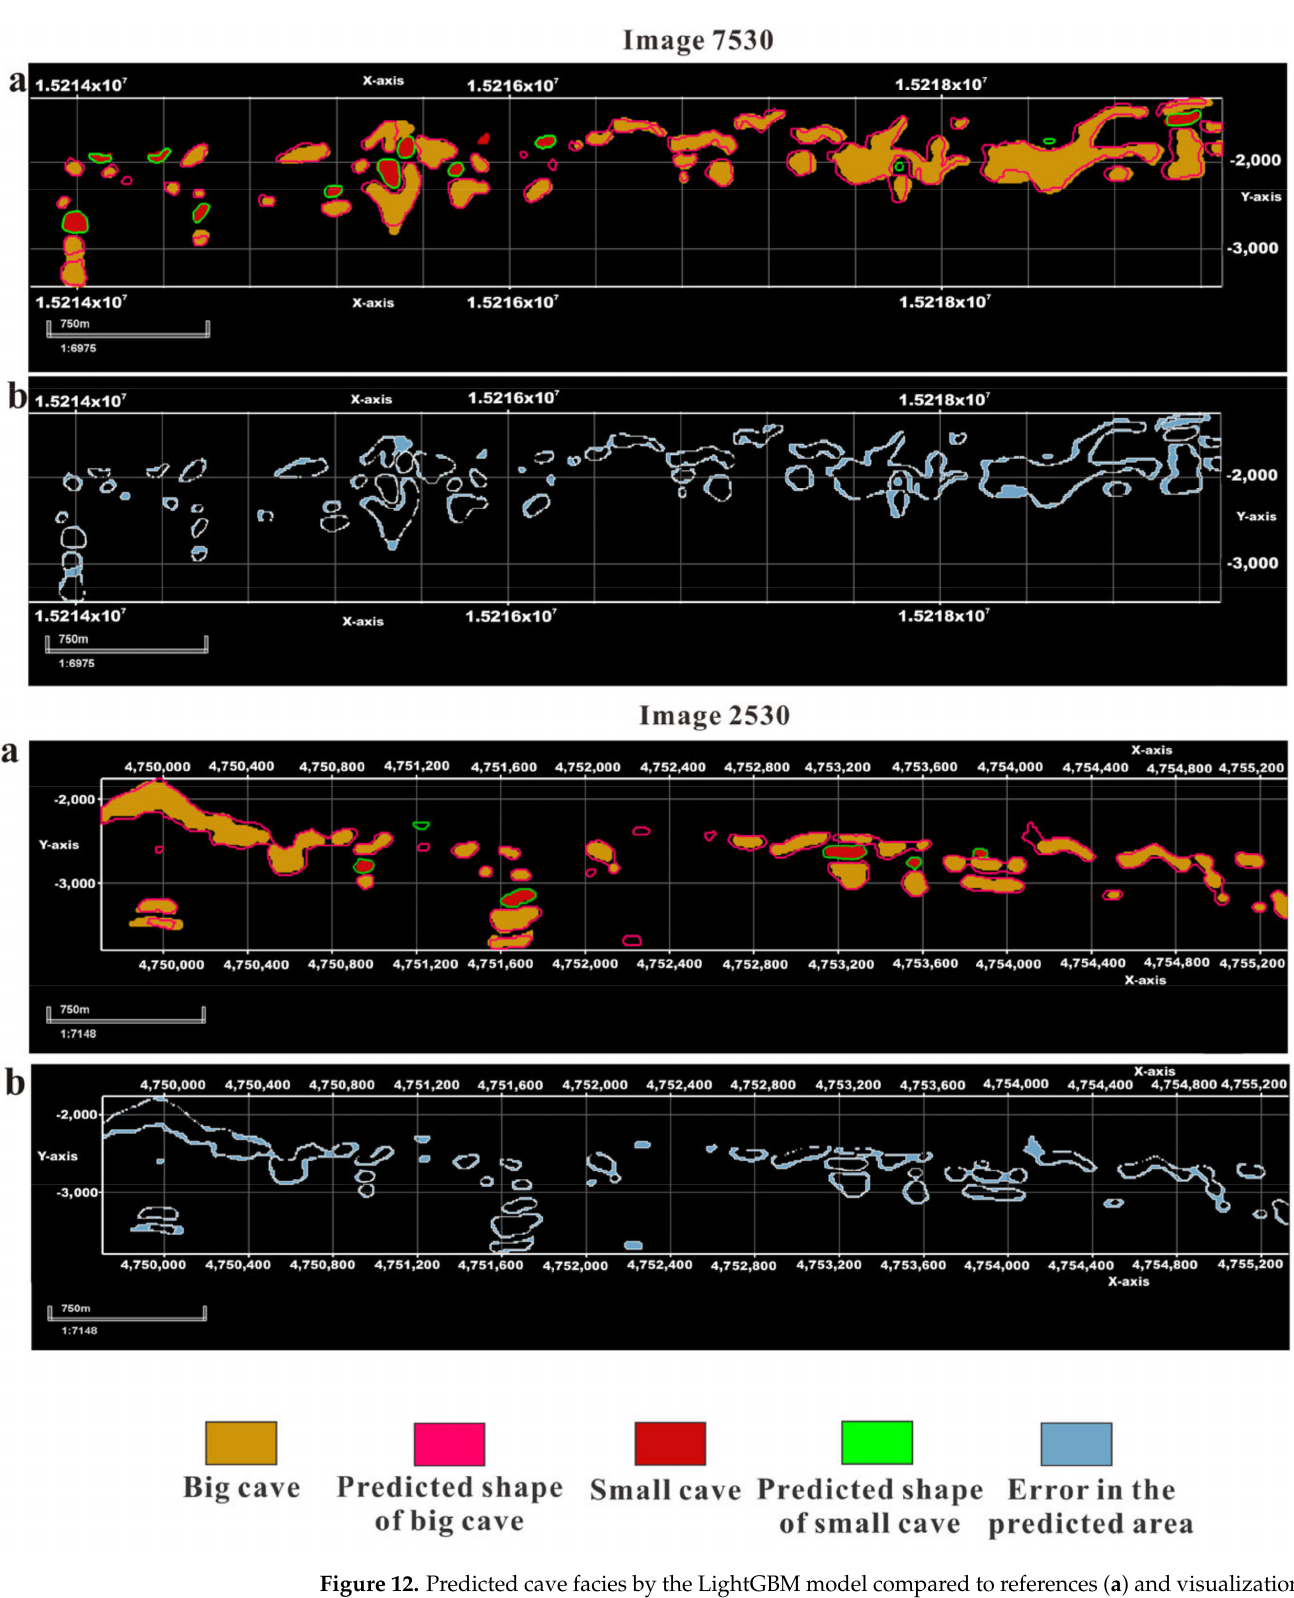
Figure 12. Predicted cave facies by the LightGBM model compared to references ( a ) and visualization of under- or overestimated cave area ( b